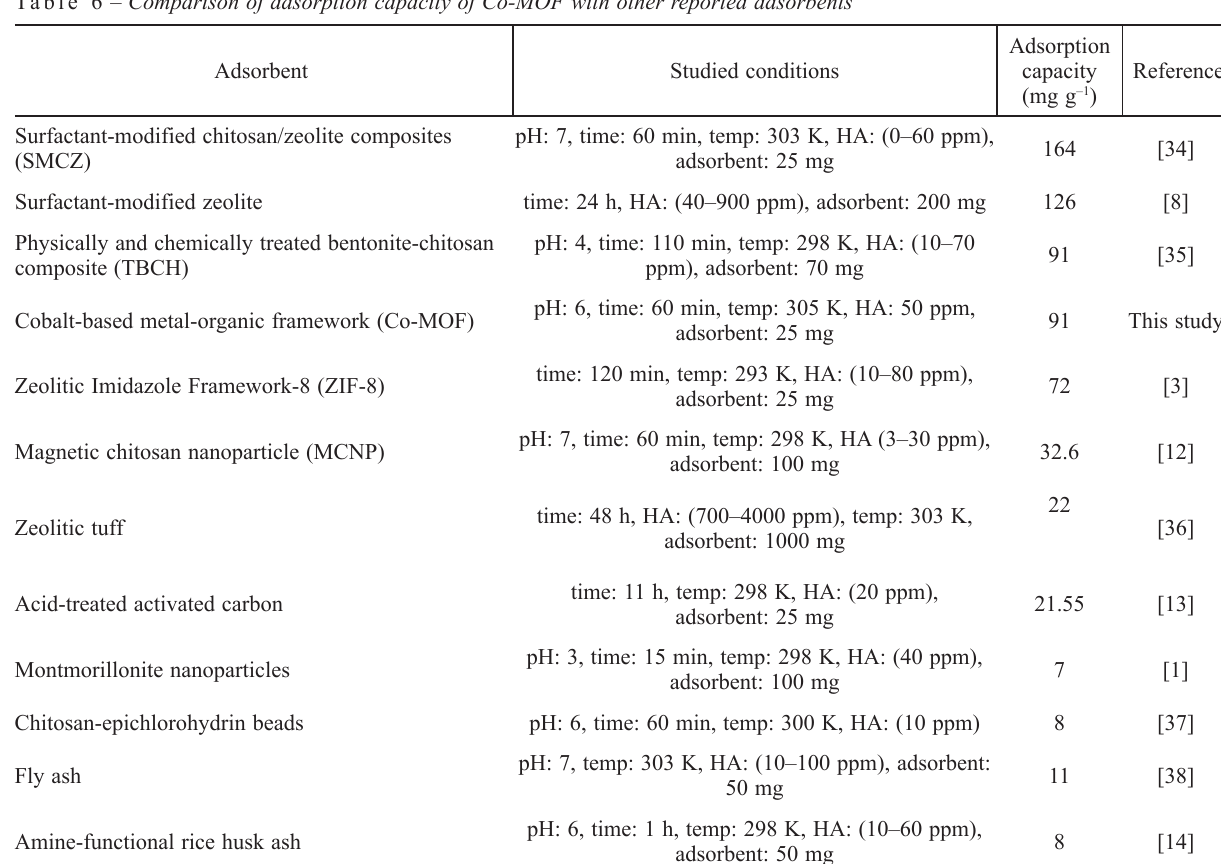
Table 6 – Comparison of adsorption capacity of Co-MOF with other reported adsorbents Adsorbent Studied conditions